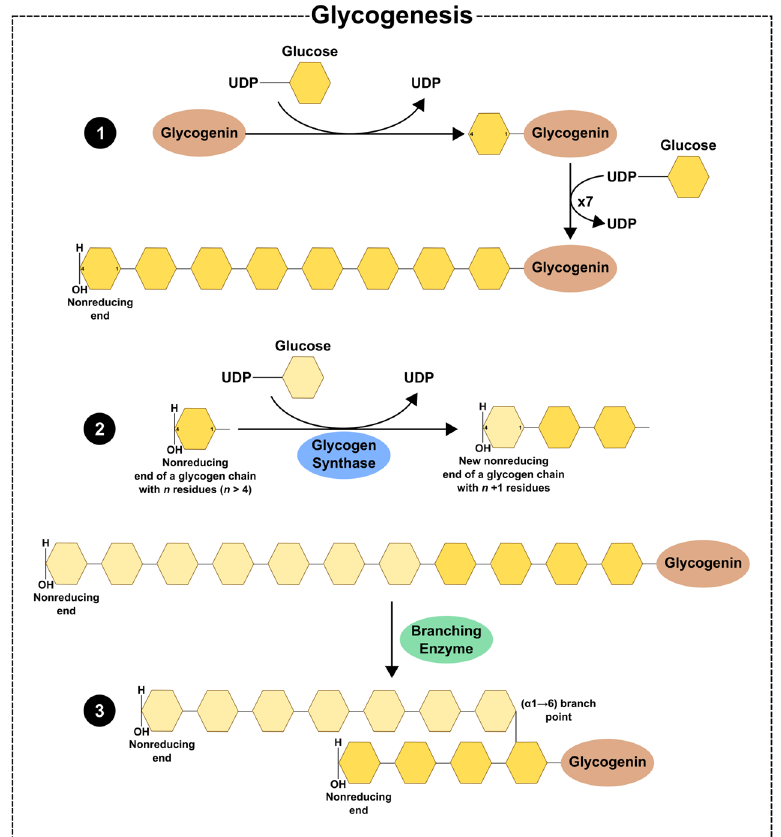
Figure 1. Schematic illustration of glycogen synthesis: (1) glycogenin catalyses the transference of glucose residues from UDP ‐ glucose to itself, forming a linear chain with residues of glucose linked by ( α‐ 1 → 4) linkages; (2) the linear chain suffers the action of glycogen synthase which creates ( α‐ 1 → 4) glycosidic linkages; (3) glycogen ‐ branching enzyme creates ( α‐ 1 → 6) glycosidic linkages, forming a highly branched polymer of glycogen.